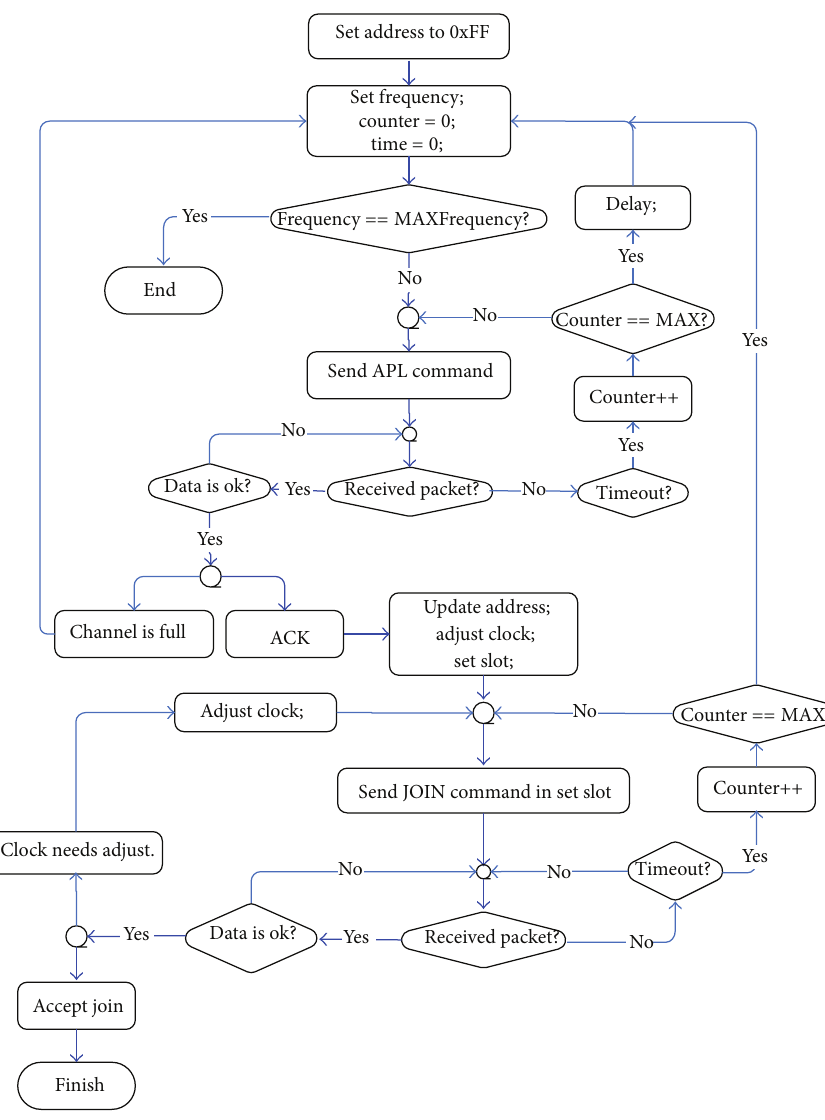
Figure 8: Simplified flowchart of node joining-ANODE/DNODE